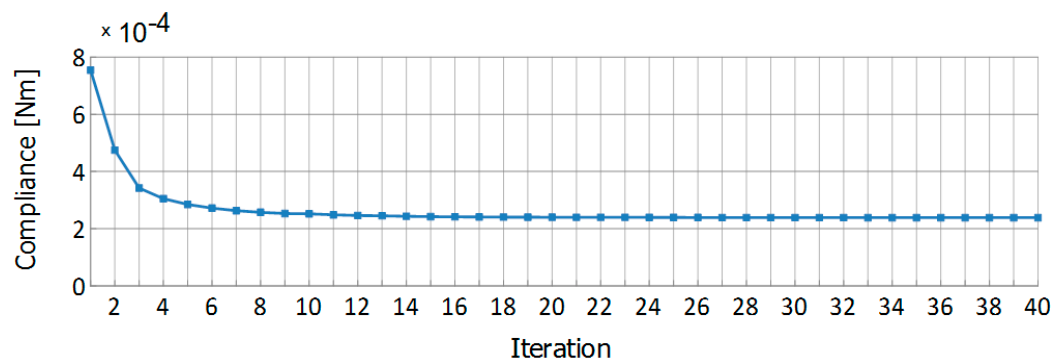
Figure 16. Iteration history for the introductory example for the mesh presented in Figure 15.